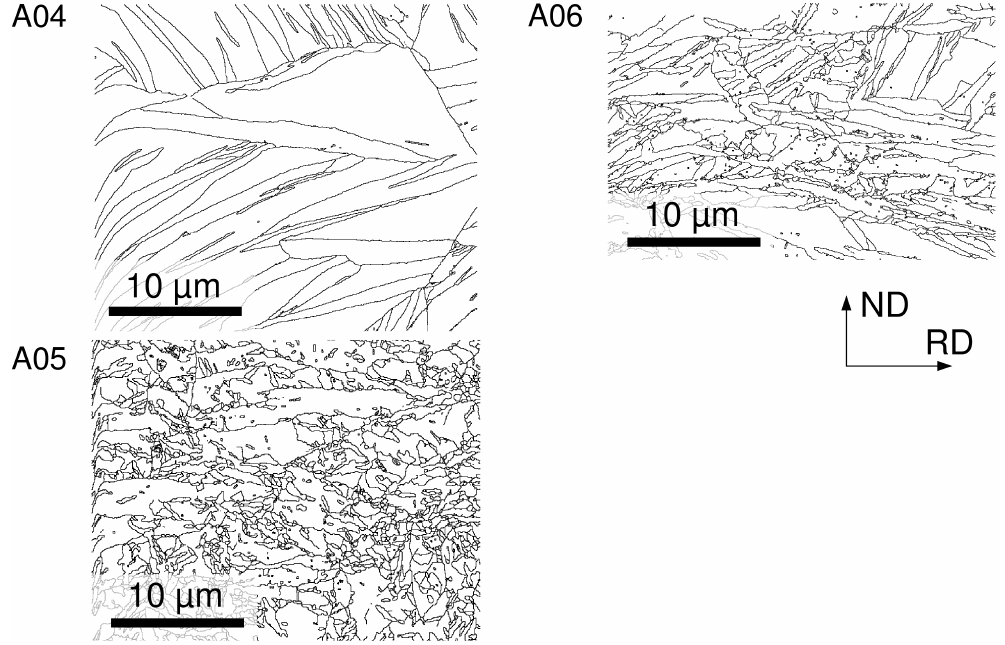
Figure 3. Grain boundary maps ( i.e. , boundaries with a misorientation angle of 15 degree and above) of DSR Ti. A04: one rolling pass, speed ratio: 1.1; A05: 1 rolling pass, speed ratio: 3.0; A06: four rolling passes, speed ratio: 1.1.